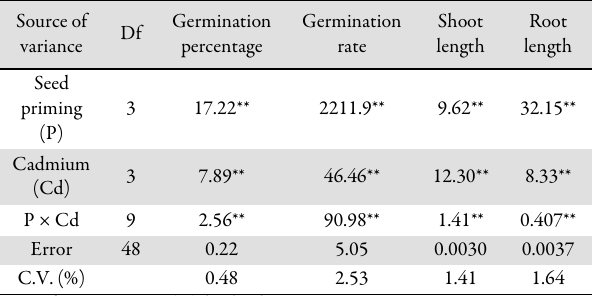
Table 1. Analysis of variance (mean square) for the effects of seed priming on the germination rate, germination percentage, shoot length and root length, of fenugreek seeds under different cadmium concentrations